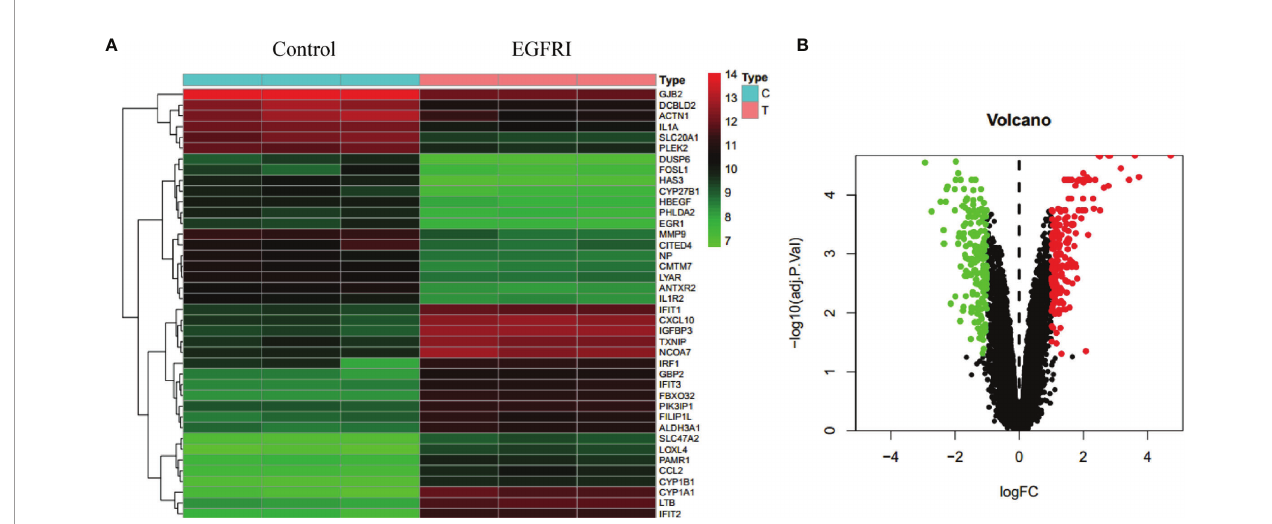
FIGURE 3 | Collection of EGFRI-related adverse skin reaction targets. (A) Heat map of the top 40 differentially expressed genes. (B) Volcano map of the top 40 differentially expressed